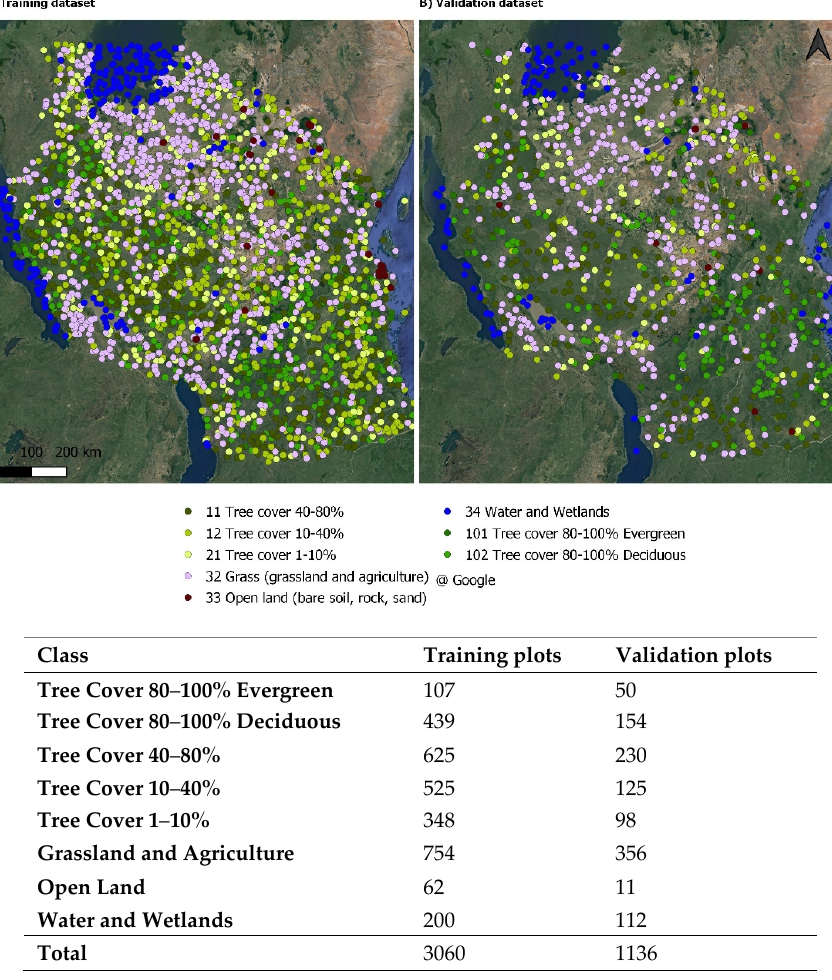
Figure 6. Spatial distribution and number of samples of the reference dataset. Maps data: Google, © 2021 Maxar Technologies.